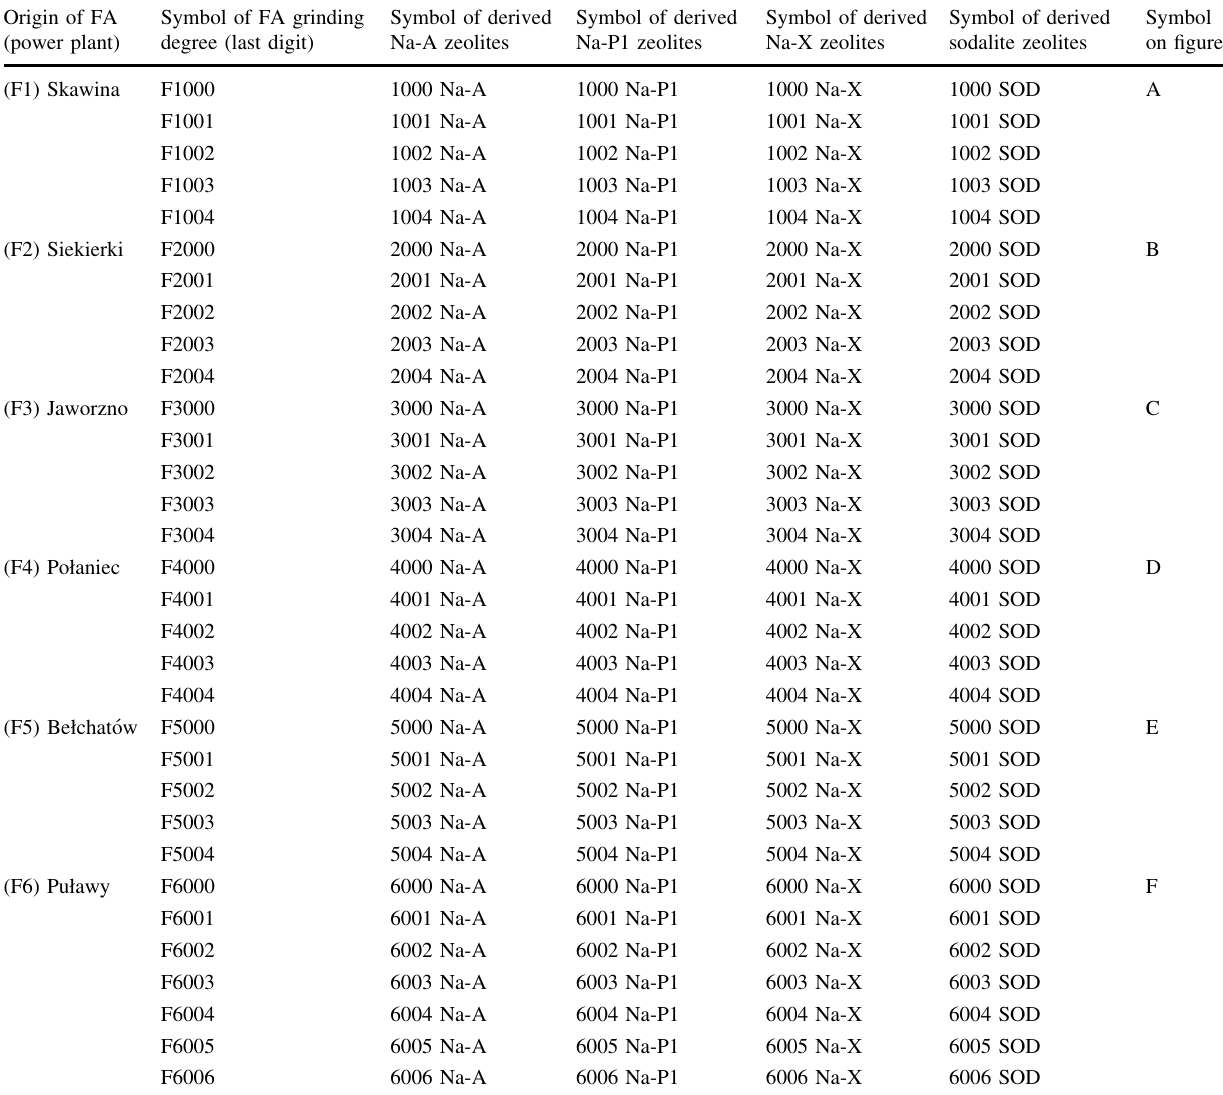
Table 2 Explanations regarding the origin and symbols denoting specific fly ashes, their ground derivatives and the zeolites obtained from them Origin of FA (power